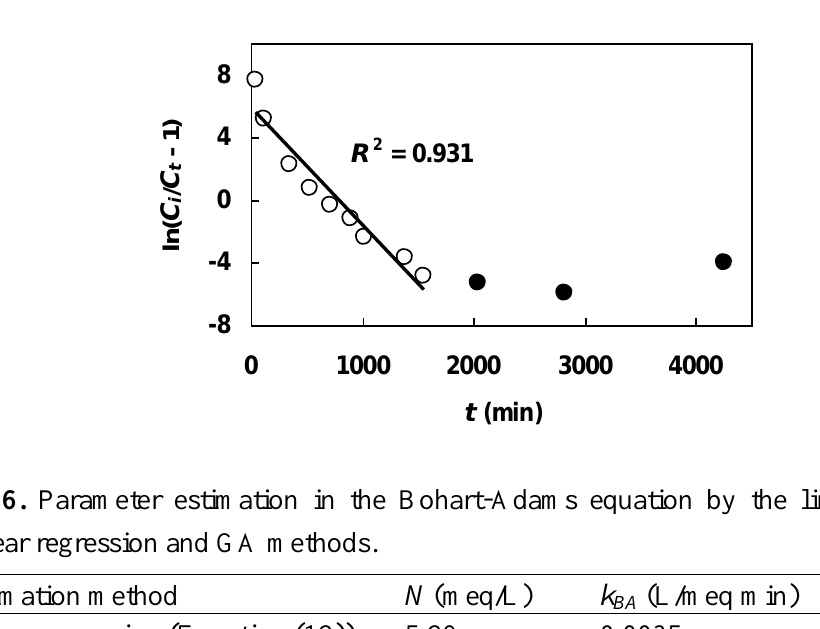
Figure 8. Breakthrough data in Figure 7 plotted according to the linearized Bohart-Adams equation (Equation (12)). Data points denoted by filled circles are excluded from the linear fit.